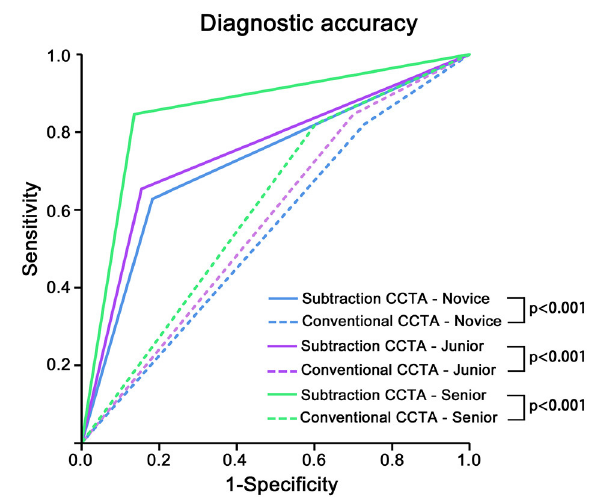
FIGURE 4 | The overall diagnostic accuracy of conventional and subtraction coronary computed tomography angiography (CCTA) for novice, junior, or senior radiologists. The overall diagnostic accuracy was calculated by the area under the curve (AUC). The solid line represents subtraction CCTA, and the dashed line represents conventional CCTA. The colors green, blue and purple represent the novice, junior, and senior radiologists, respectively. The AUC of subtraction CCTA was significantly higher than that of conventional CCTA in each radiologist group stratified by working experience (all p <